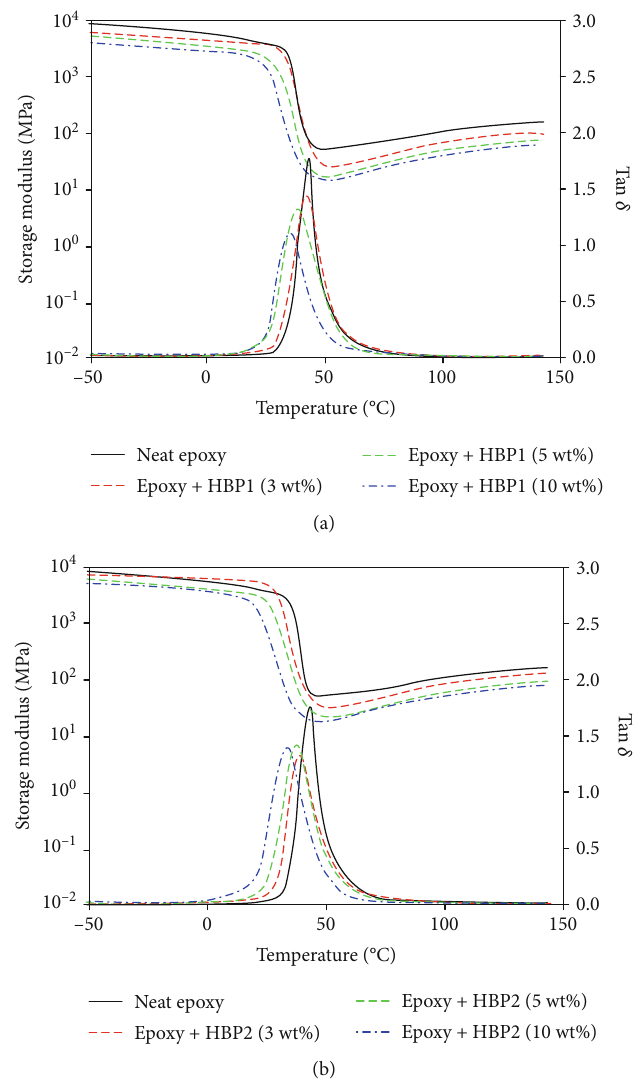
Figure 3: DMA curves of (a) epoxy/HBP1-3.0 K and (b) epoxy/HBP2-3.1 K